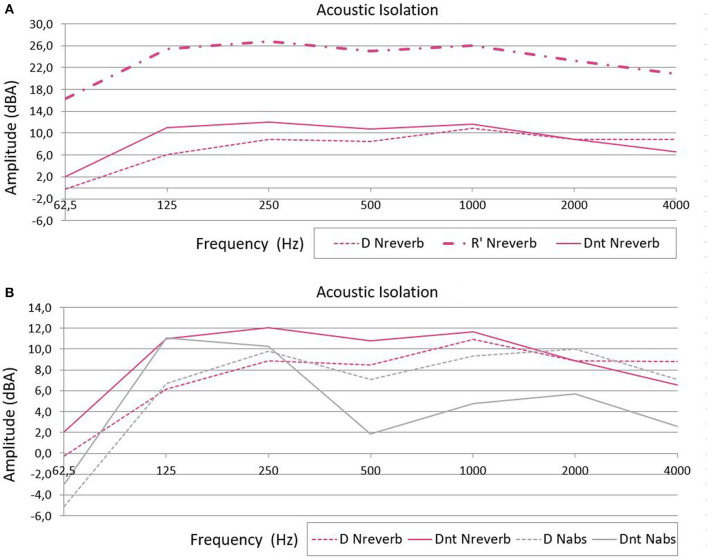
(A) Level difference (D), apparent sound reduction index (R′), and standardized level difference (DnT) isolation indexes (in dBA) for the incubator in the reverberant room. (B) Comparison of the level difference (D) and standardized level difference (DnT) isolation indexes of the acoustic absorbent (Nabs, gray) and reverberant (Nreverb, pink) rooms.